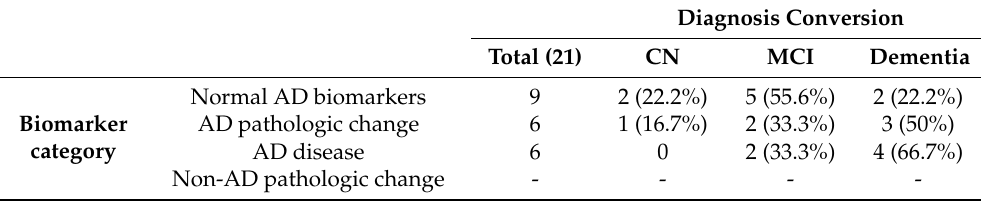
Table 5. Mild cognitive impairment (MCI) prospective clinical status based on biomarker category classification.